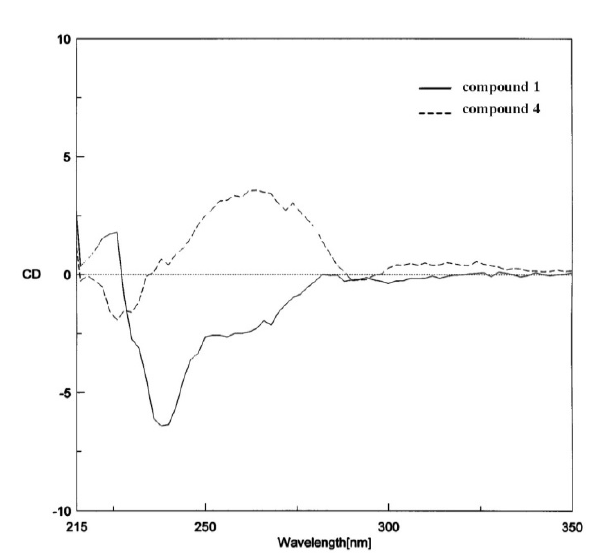
Figure 2. CD data of compounds 1 and